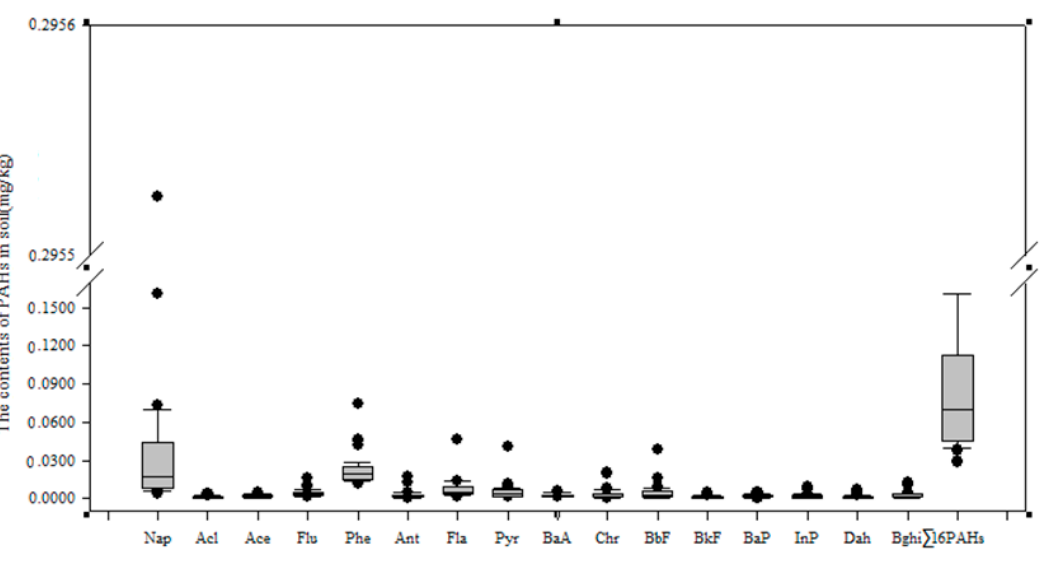
Figure 2. The polycyclic aromatic hydrocarbon (PAHs) content in the soils of the Momoge Wetland.